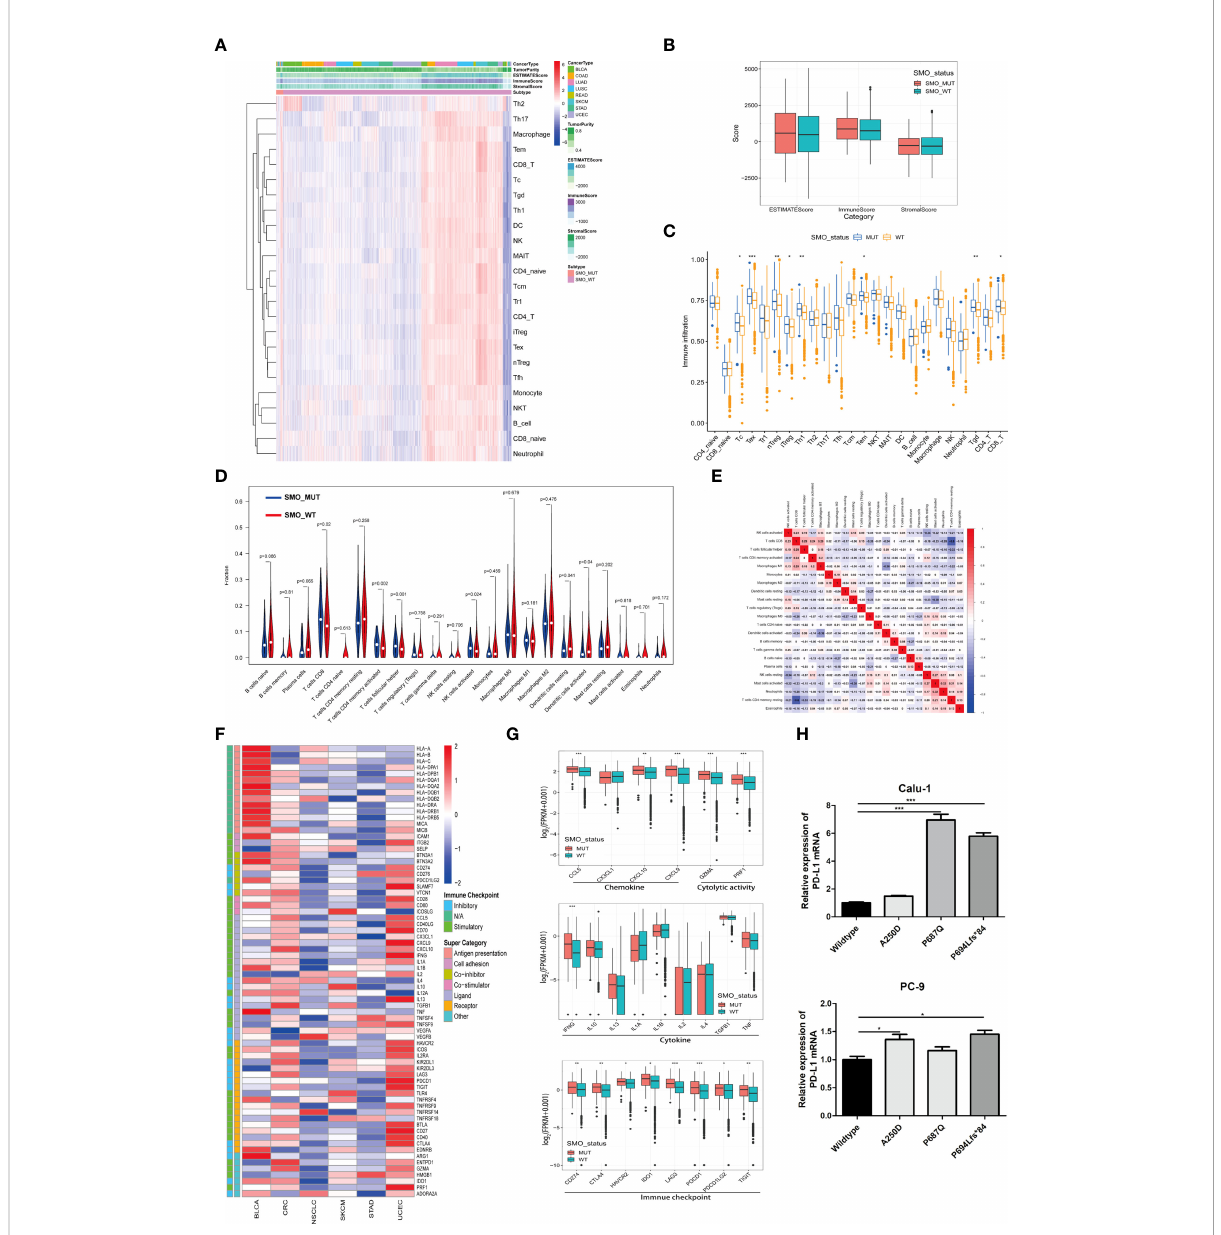
FIGURE 6 Relationship between SMO mutation and the antitumor immune microenvironment. (A) Heatmap illustrating the hierarchical clustering of immune cell signaling in pan-cancers between SMO mutant (SMO_MUT) and SMO wild-type (SMO_WT) tumors. Immune cell signaling enrichment was quanti fi ed by the single-sample gene set enrichment analysis (ssGSEA) score in each tumor sample. The stromal score, immune score, and ESTIMATE score were evaluated by ESTIMATE (Estimation of Stromal and Immune Cells in Malignant Tumor Tissues using Expression data). (B) Comparison of the ESTIMATE score, stromal score, and immune score in SMO_MUT and SMO_WT tumors (two-tailed Mann – Whitney U test). (C) Box plot depicting the comparison of the immune cell in fi ltration levels in SMO_MUT and SMO_WT tumors based on the ssGSEA scores of 24 immune cell signals (two-tailed Mann – Whitney U test). (D) Violin plot indicating the in fi ltration composition ratio of 22 immune cells in SMO_MUT and SMO_WT tumors. CIBERSORT was used to calculate the in fi ltration degree of these immune cells. (E) Different correlation patterns among the 22 immune cell subsets in The Cancer Genome Atlas (TCGA) pan-cancer cohort. (F) Heatmap depicting the log 2 -transformed fold change in the expression levels of immune-related genes across multiple cancer types (SMO_MUT vs . SMO_WT). Blue indicates downregulation and red indicates upregulation. (G) Box plot depicting the expression levels of the different types of immune-related genes, such as chemokines, cytolytic activity, immune checkpoint, and cytokine, between the SMO_MUT and SMO_WT groups (two-tailed Mann – Whitney U test). (H) Real-time PCR analysis of programmed cell death ligand 1 (PD-L1) expression after being transfected with SMO_MUT plasmids in non-small cell lung cancer (NSCLC) cell lines (one-way ANOVA). * p < 0.05, ** p < 0.01, *** p <